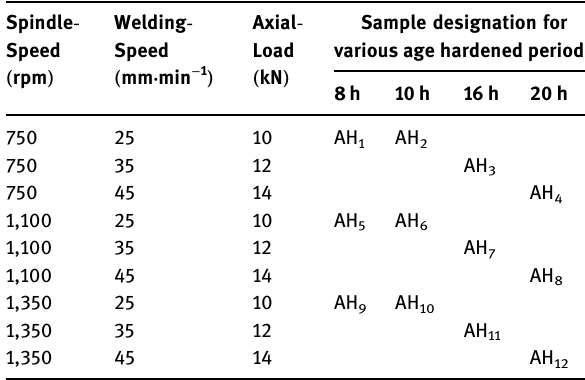
Table 4: Sample ID for di ff erent process parameters Spindle - Welding -